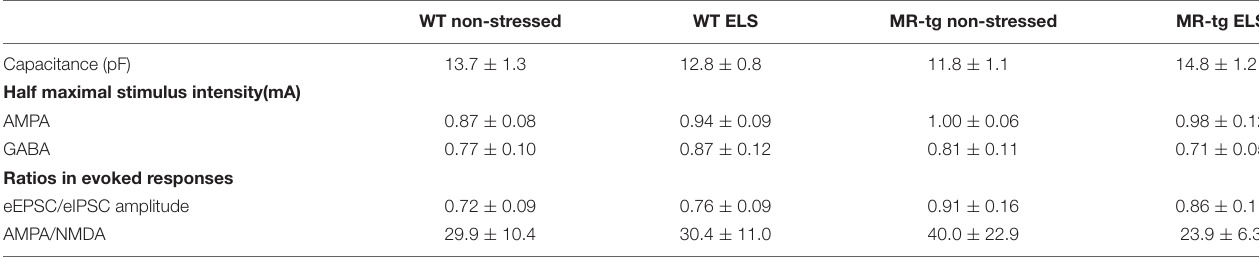
TABLE 1 | Capacitance of granule cells in the dentate gyrus ( n = 11 per group); and half maximal stimulus intensity, eEPSC/eIPSC as well as AMPA/NMDA ratios ( n = 8–10 cells per